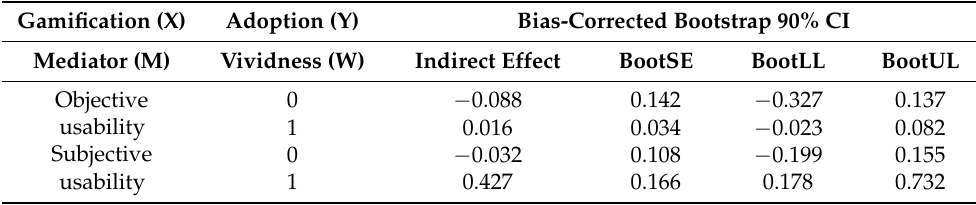
Table 13. Indirect effects of gamification on adoption via objective and subjective usability and the vividness of presentation of in-person